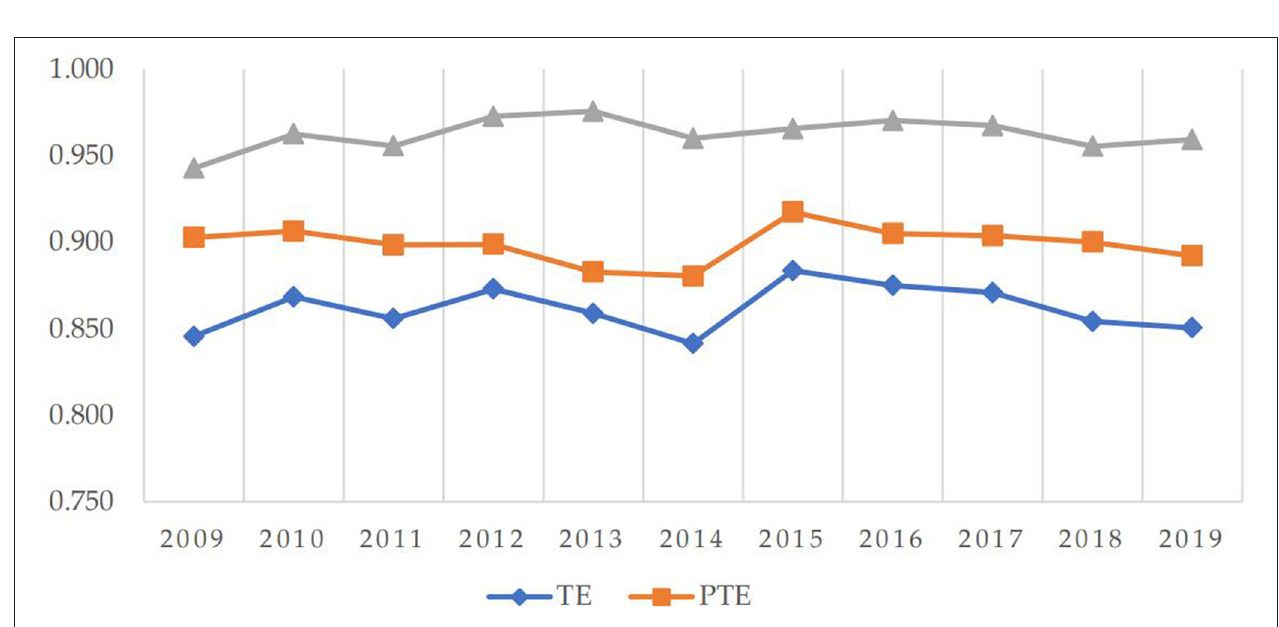
FIGURE 1 | Health production efficiencies of National and four regions from 2009 to 2019.